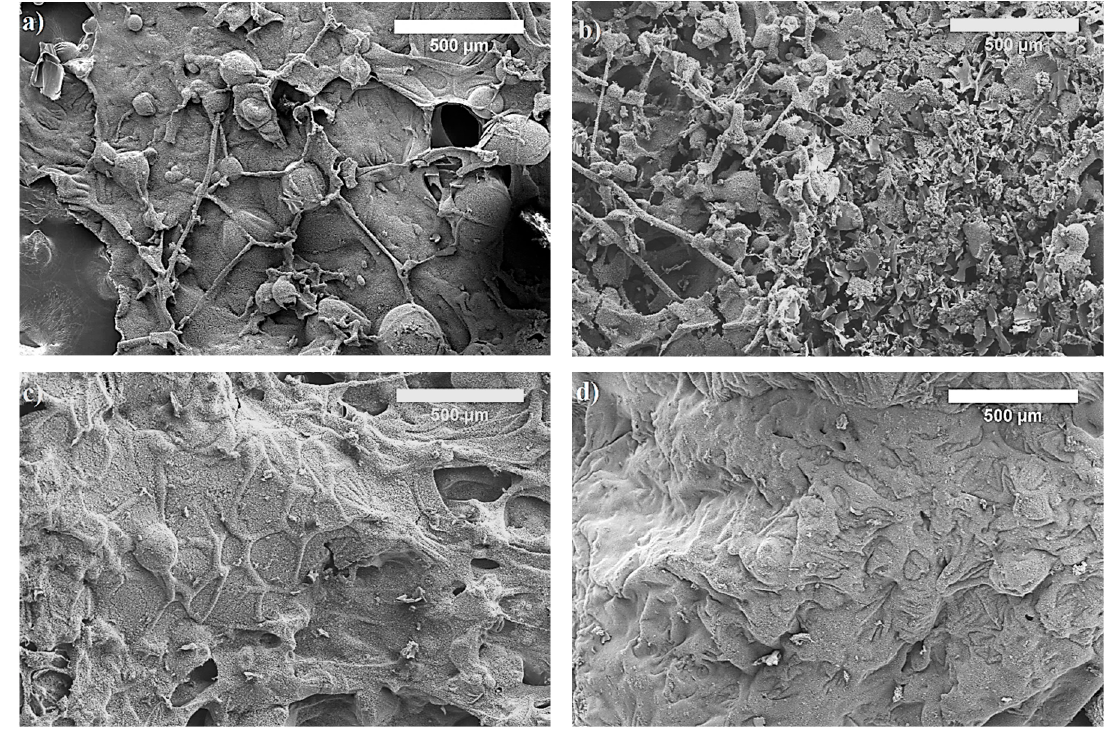
Figure 5. SEM images of PU and WAPU foams char after cone calorimeter tests: ( a ) PU; ( b ) WAPU-10; ( c ) WAPU-30, and ( d ) WAPU-50.